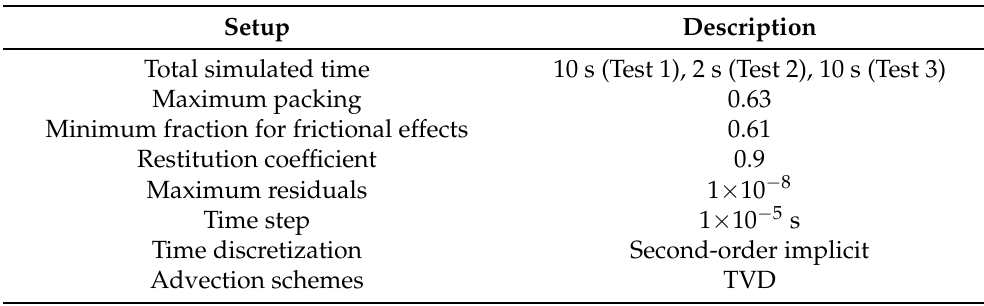
Table 2. Numerical